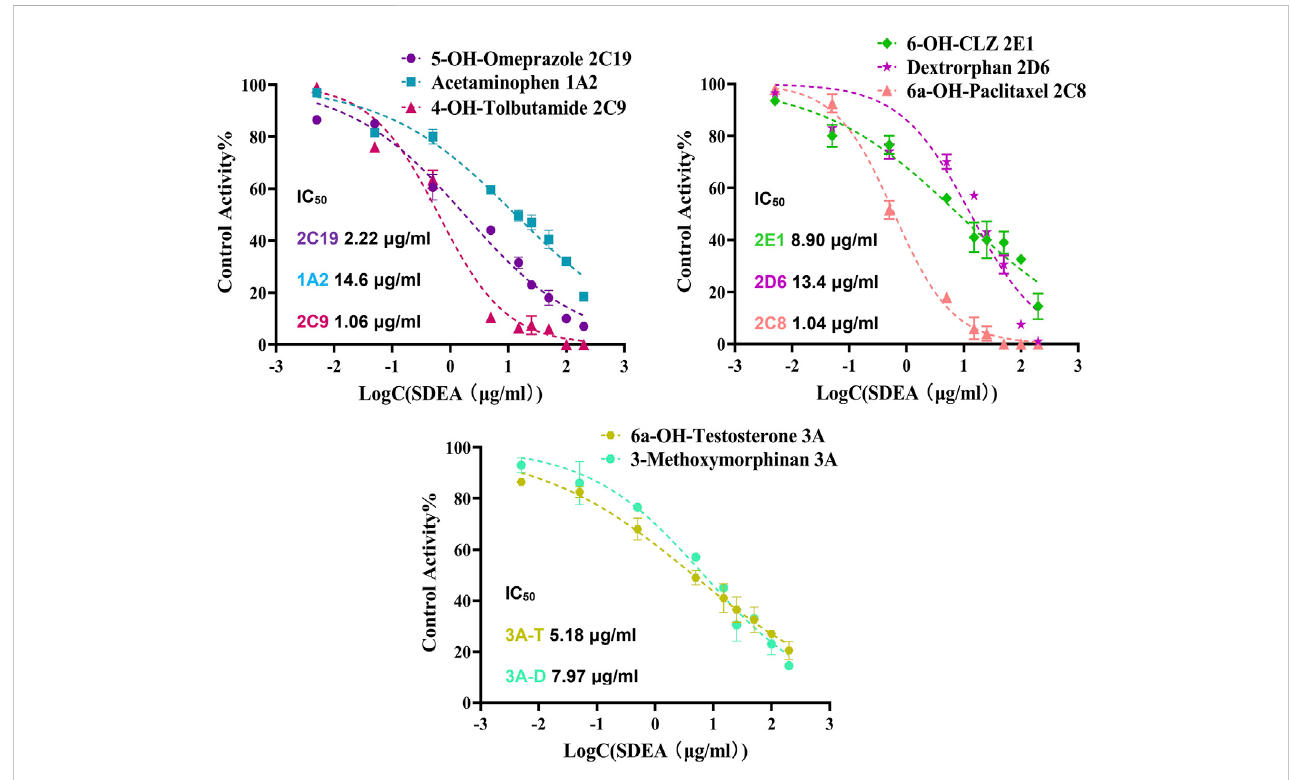
FIGURE 3 Inhibitory potency curves and IC 50 values of SDEA on seven CYP450 enzyme isoforms. Note: 3A-T, CYP3A (Testosterone); 3A-D, CYP3A (Dextromethorphan).